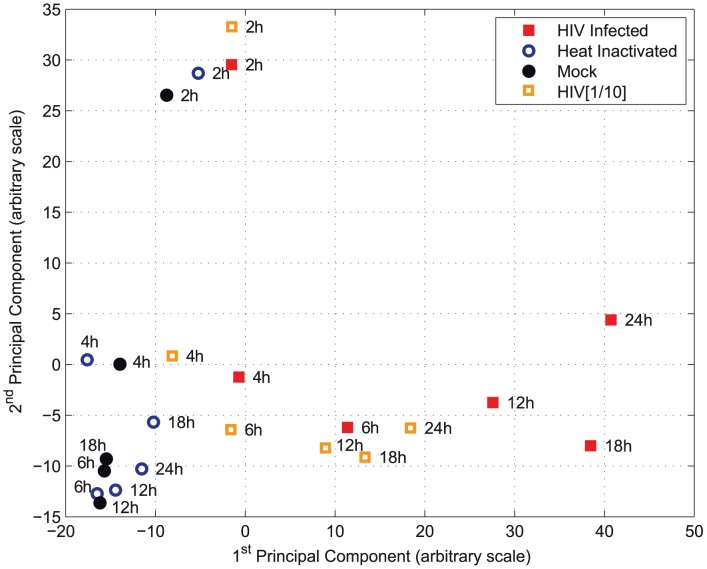
Transcriptome changes upon exposure to infectious and non-infectious viral particles.Principal component analysis is used to explore the overall variance structure of the transcriptome datasets. With each point representing a whole transcriptome sample, the figure presents the transcriptome of cells that were universally infected (HIV), cells exposed to heat-inactivated virus (Heat-inactivated), cells exposed to a mixture of 1∶10 infectious/heat-inactivated virus (HIV[1/10]), and non-infected cells (Mock). One mock sample failed and is not plotted. The transcriptome of mock cells and that of cells exposed to heat-inactivated viruses clustered together across the top principal components. Infected cells, on the other hand, spread away from the mock space as infection progressed, with the most distant dot corresponding to the latest time point (24 h). The mixture 1/10 infectious/noninfectious material occupies the intermediate space. Clustering of the two hours samples corresponds to end of cell exposure to the virus or control materials.